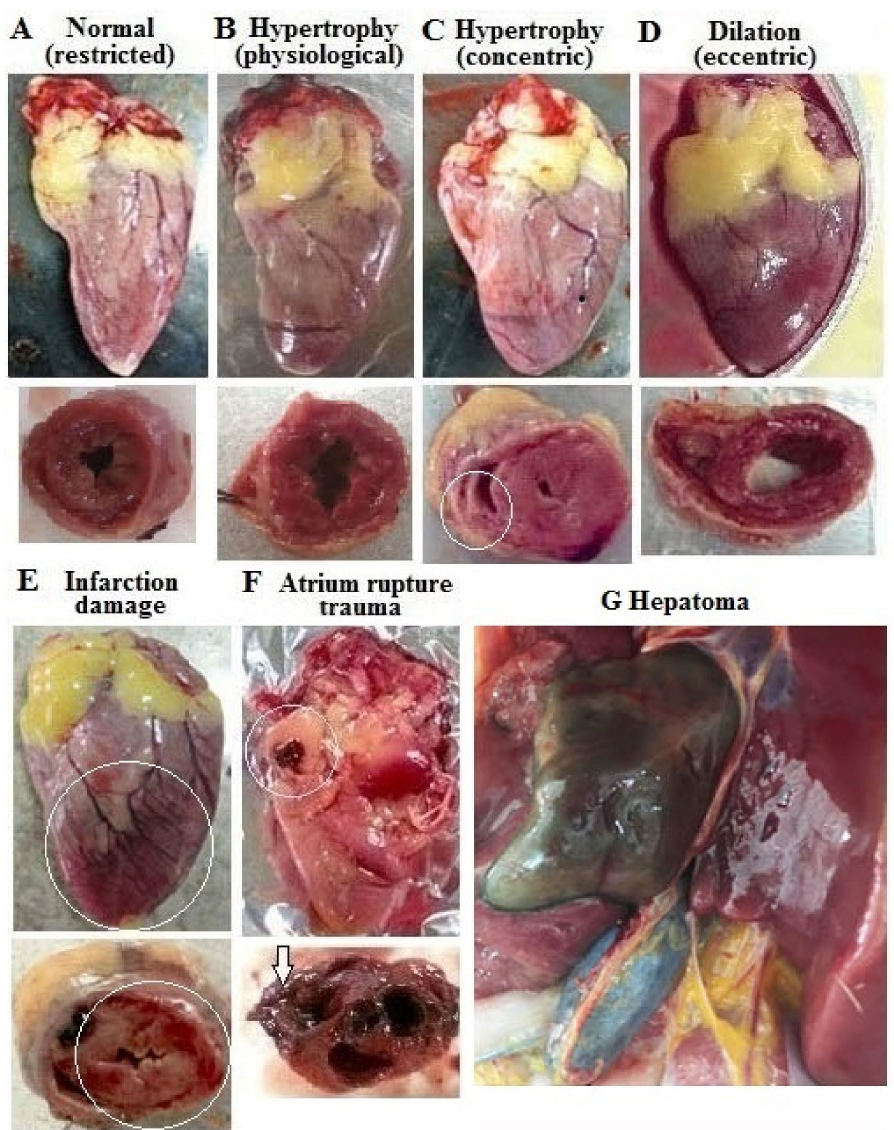
Figure 1. Cardiac morphology and hepatoma of in di ff erent diet groups of broiler breeder hens. Hens at age of 29, 35, and 47 weeks (n = 4, 7, 7 from each group, respectively) were sampled for tissue collection and cardiac morphology examination. Gross and cross sections showed a heart with normal physical dimensions ( A ), physiological hypertrophy ( B ), concentric hypertrophy (note the thickened septum, right and left ventricle wall and resultant reduction in ventricular chamber dimensions, ( C ), dilation (note soft and collapsed myocardium with enlarged ventricular chamber dimensions, indicative of a “flabby heart”, ( D ), infarction damage (note dark red with yellowish color of the cross section, circled, ( E ) and atrium rupture (note break in tissue integrity, circled and arrow from sudden death (SD) mortalities, ( F ). One hens from Ad-group sampled at 47 weeks was found with hepatoma (noted for dark green regions, ( G ). 25-OH-D3;